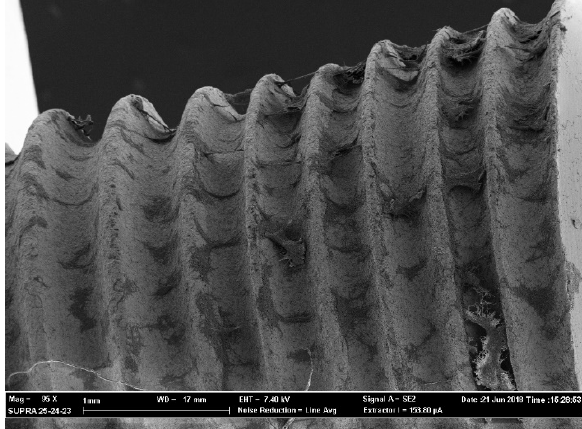
Figure 5. CHX treatment on a sandblasted implant. Magnification 95×.